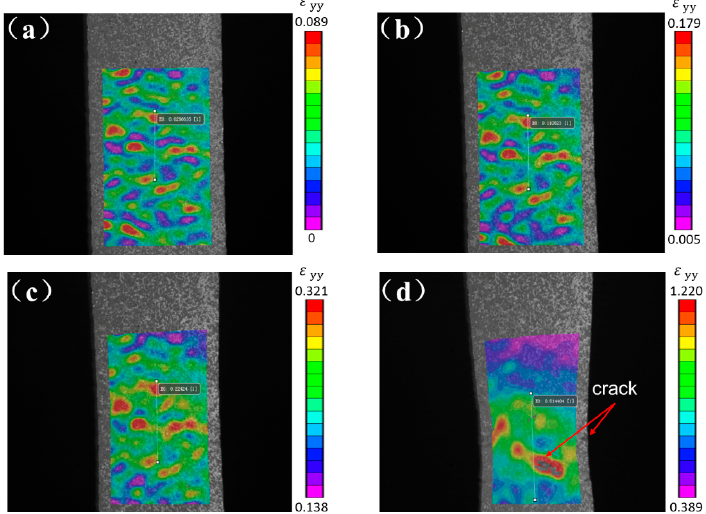
Figure 5. The full-field ε yy stain mapping of TW specimens during the creep test at 1 h ( a ), 20 h ( b ), 40 h ( c ) and 60 h ( d